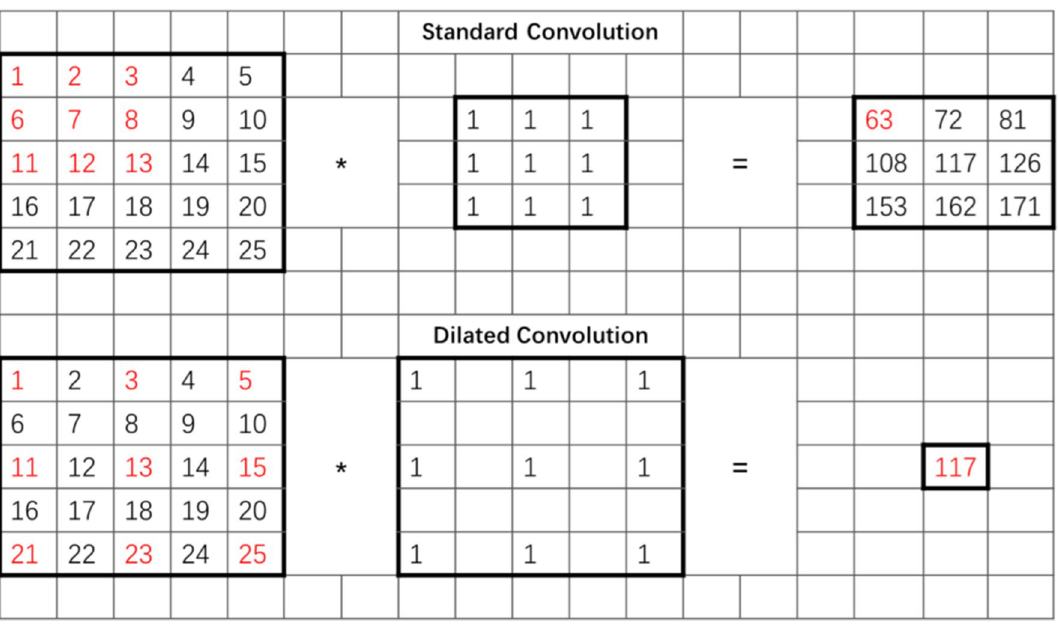
Figure 4. The difference between the reception field and the output of standard convolution and dilated